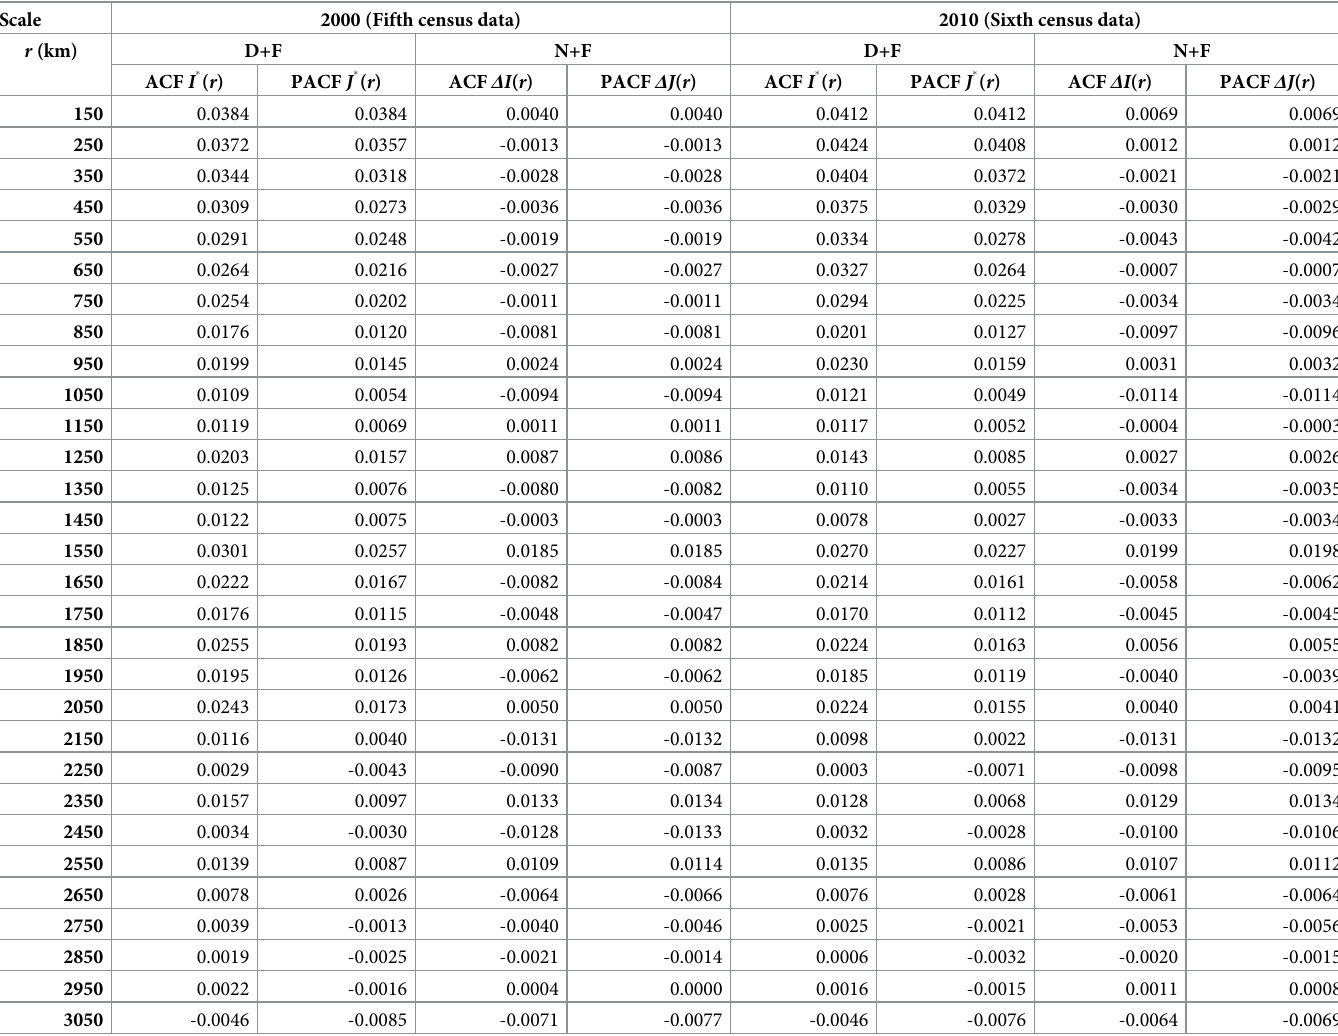
Table 2. Datasets for spatial autocorrelation function (ACF) and partial spatial autocorrelation function (PACF) based on Moran’s index (partial